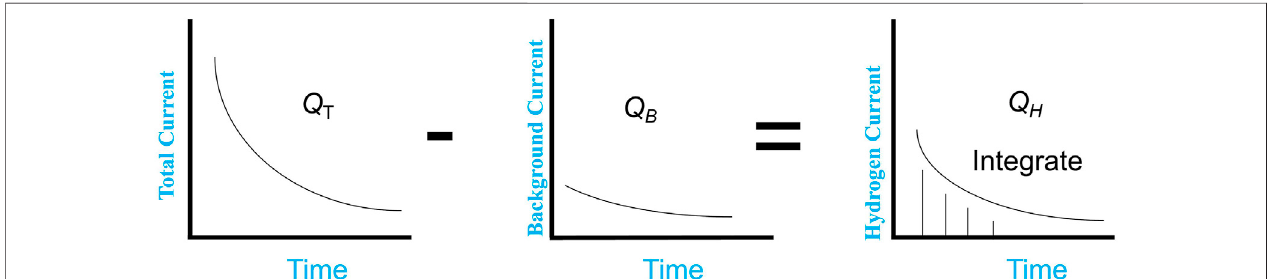
FIGURE 4 | Calculation method of hydrogen